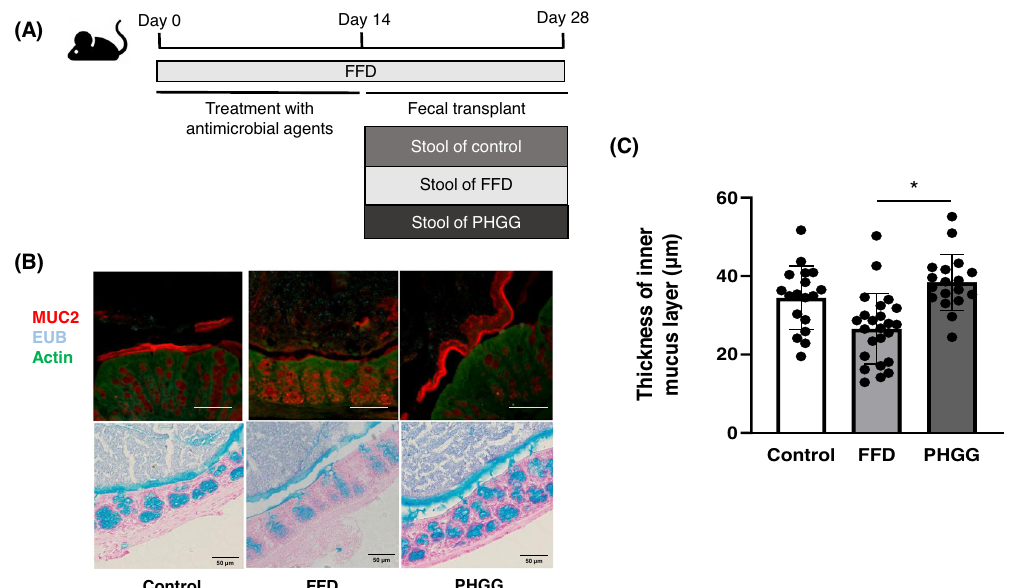
Fig. 4 Thickness of the colon mucus layer in fecal transplant model mice. A Schematic diagram of the stool transplant mouse model. B Fluorescent immunostaining of MUC2 in the colon of mice and alcian blue staining of sections of the colon. Scale bars, 50 μ m. C Measurement of the colonic mucus layer thickness. In each group, the colonic mucus layer thickness was measured at nine points and the means were compared. Error bars represent the SEM. (* p <